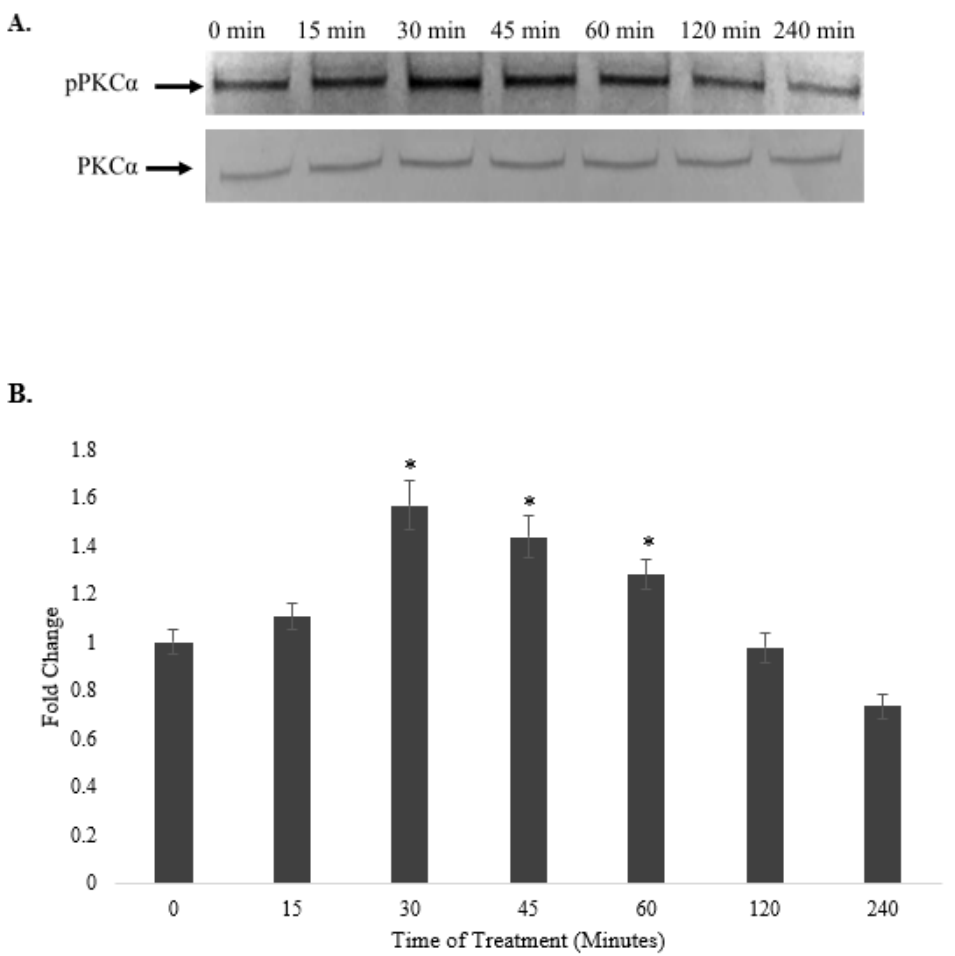
Figure 9. Time-course study on the effects of A. planci on the phosphorylation of PKC α . HepG2 cells were either untreated or treated with 6.25 µ g/mL of selected A. planci fraction over a period of 4 h. Isolated cytoplasmic extracts were subjected to Western blot analysis using antibodies against total and phospho-PKC α ( A ). The levels of protein expression for phospho-PKC α were normalized against those for total PKC α , and the value at each time point represents the fold change in normalized phospho-PKC α protein expression relative to the untreated control, which is assigned to 1. * Indicates that the value at a particular time point was significantly higher than that of the untreated control ( B ).